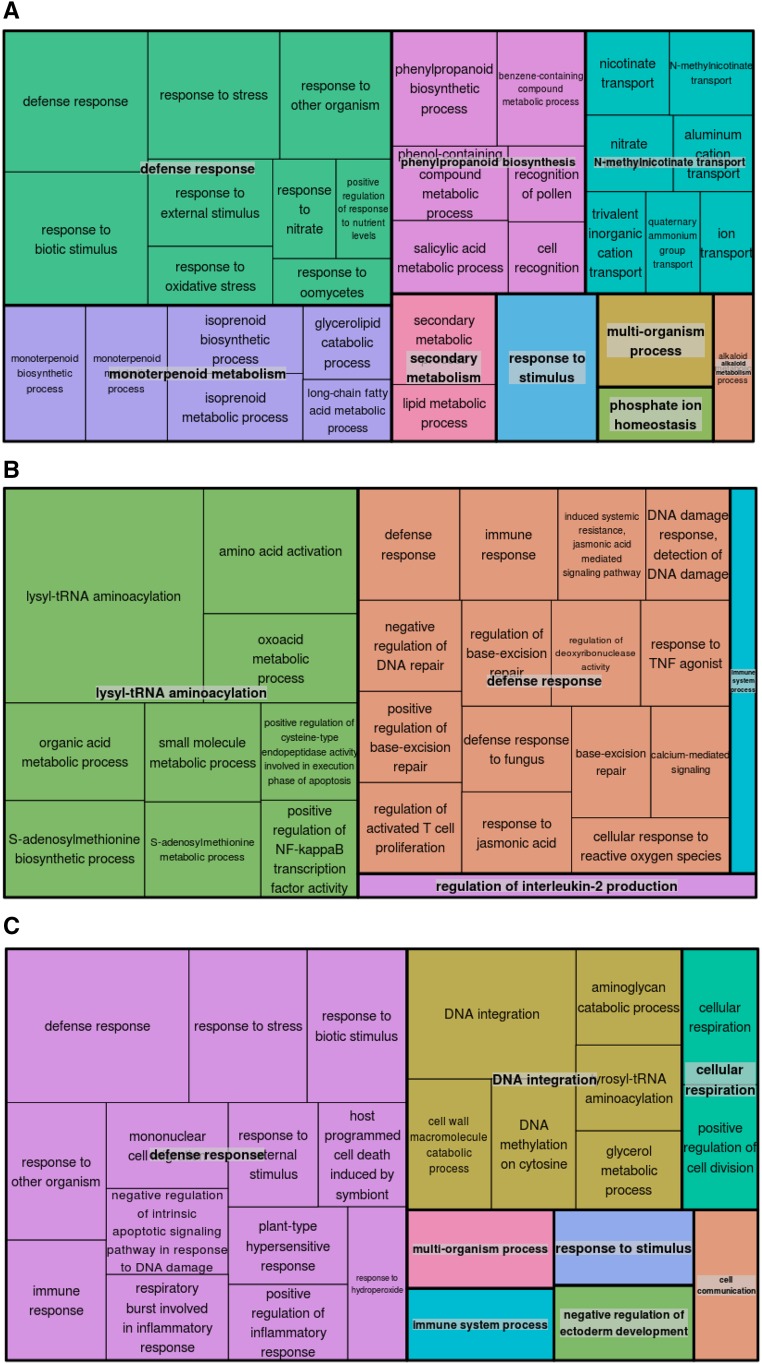
GO enrichment analysis for DEGs. Treemap containing most significant enriched GO terms (biological process) during drought stress, visualized with REVIGO for (A) Q. robur, (B) Q. pubescens and (C) Q. ilex, respectively.